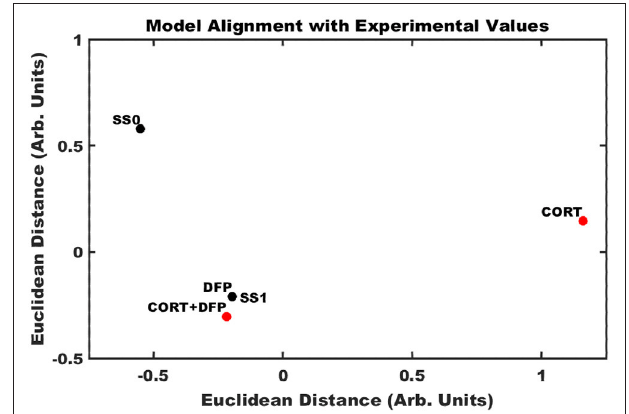
FIGURE 3 | Alignment of exposure conditions compared to saline controls with model predicted stable states. Sammon projection in two dimensions for gene expression obtained in cortex. Black dots represent the model predicted stable states (SS0, and SS1). Red dots represent the aggregated gene expression data for CORT, DFP, and CORT + DFP exposure conditions vs. saline controls. Axes represent arbitrary units such that the relative distance between points approximates the aggregated P -values between all